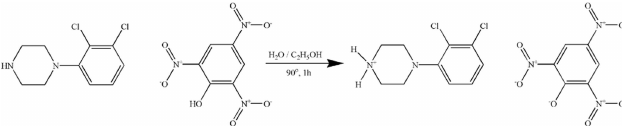
Figure 5 Reaction scheme.